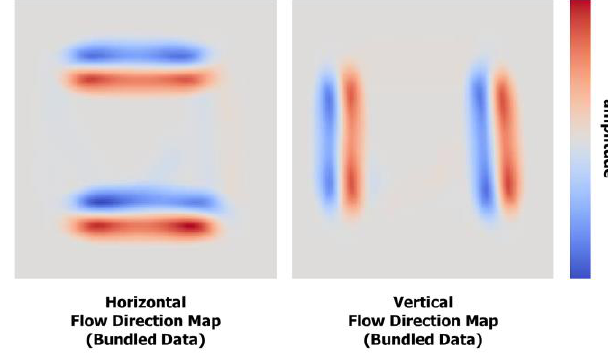
Figure 4. Visualization of the horizontal (on the left) and vertical (on the right) components of the flow direction map of the square scanpath after fixation clustering and saccades